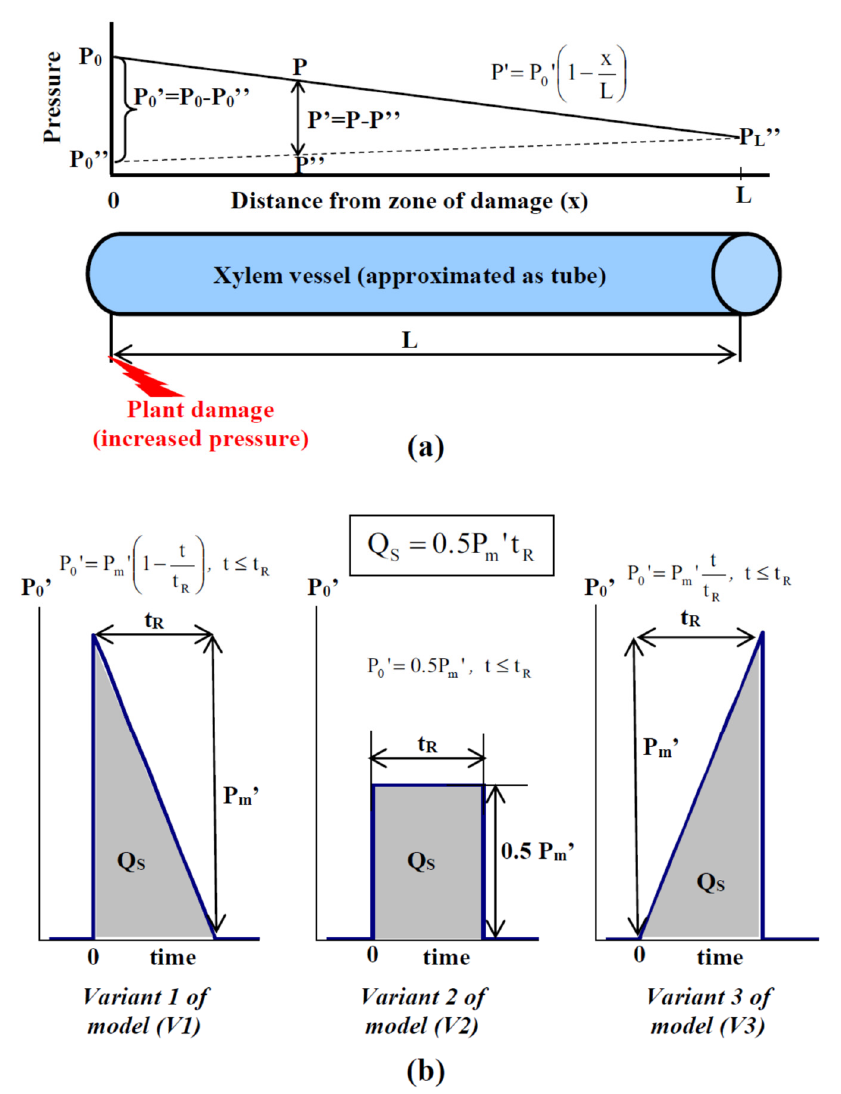
Figure 1. (a) Scheme of the pressure distribution in a xylem vessel, which is approximated by a tube of length equaling to L. P 0 ’’, P L ’’, and P’’ are pressures without damage in the initial (x = 0), terminal (x = L), and intermediate (0 < x < L) points of the vessel, respectively; it is assumed that P 0 ’’, P L ’’, and P’’ are not dependent on time; P’’ is a linear function of x (see Equation (3) in Section 2). P 0 and P are pressures in the initial (x = 0) and intermediate (0 < x < L) points of the vessel, respectively, after the start of action of a stressor; they are time dependent, and P is also dependent on x. P 0 ’ and P’ are the increases in pressure above pressure values without stimulation. It is also assumed that a stimulation acts on the initial point of the vessel and induces the transient increase in P 0 ’ and, therefore, P’. The equation that describes the relations between P 0 ’ and P’ is also shown in the figure (see Section 2 for details). (b) Variants of stimulation-induced increases in pressure (P 0 ’) that are used in our analysis. An instant initial increase in pressure and a subsequent linear decrease during the time of response (t R ) are assumed for Variant 1 (V1) of the variation potential (VP) propagation model. V1 is in accordance with the short-term and highly intensive action of damages (e.g., burning or crush, which are widely used damages for VP induction [1,5]). Constant increased pressure during the time of response is assumed for Variant 2 (V2) of the model. V2 is in accordance with the long-term and constant action of a stressor (e.g., an artificial increase in pressure in a part of the shoot, which was used in some experiments [44]). The long-term increase in pressure during t R and its instant decrease after that are assumed for Variant 3 (V3) of the model. V3 most probably is in accordance